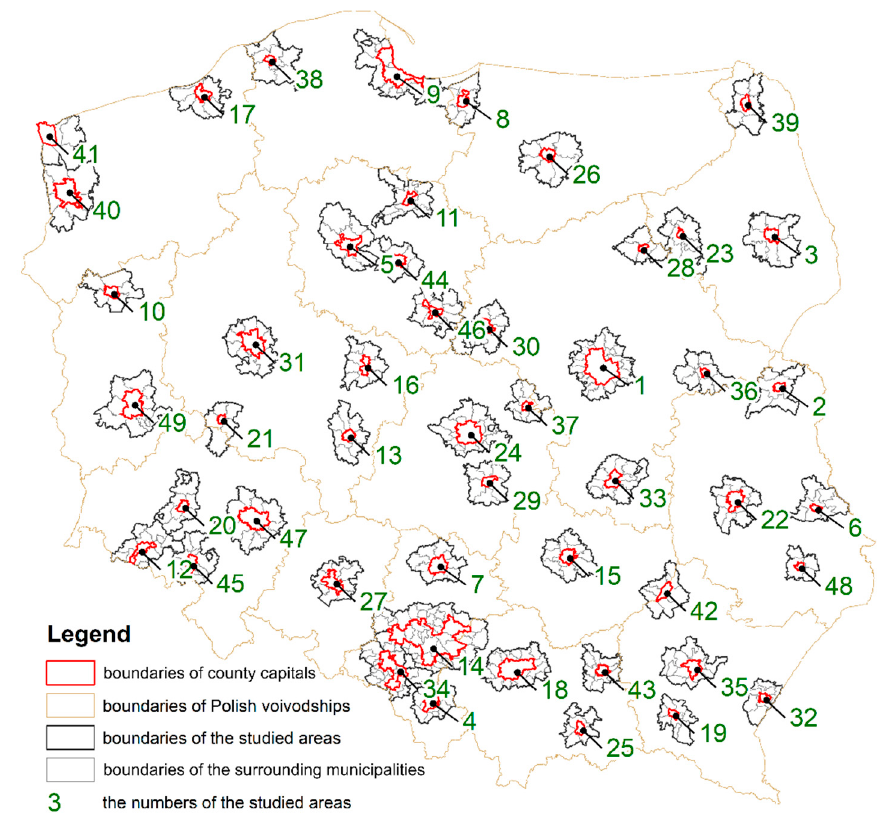
Figure 4. Source: own elaboration.